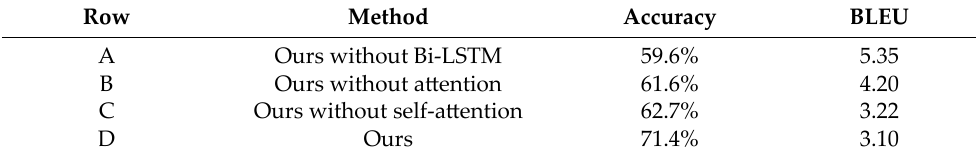
Table 7. Ablation experimental results.